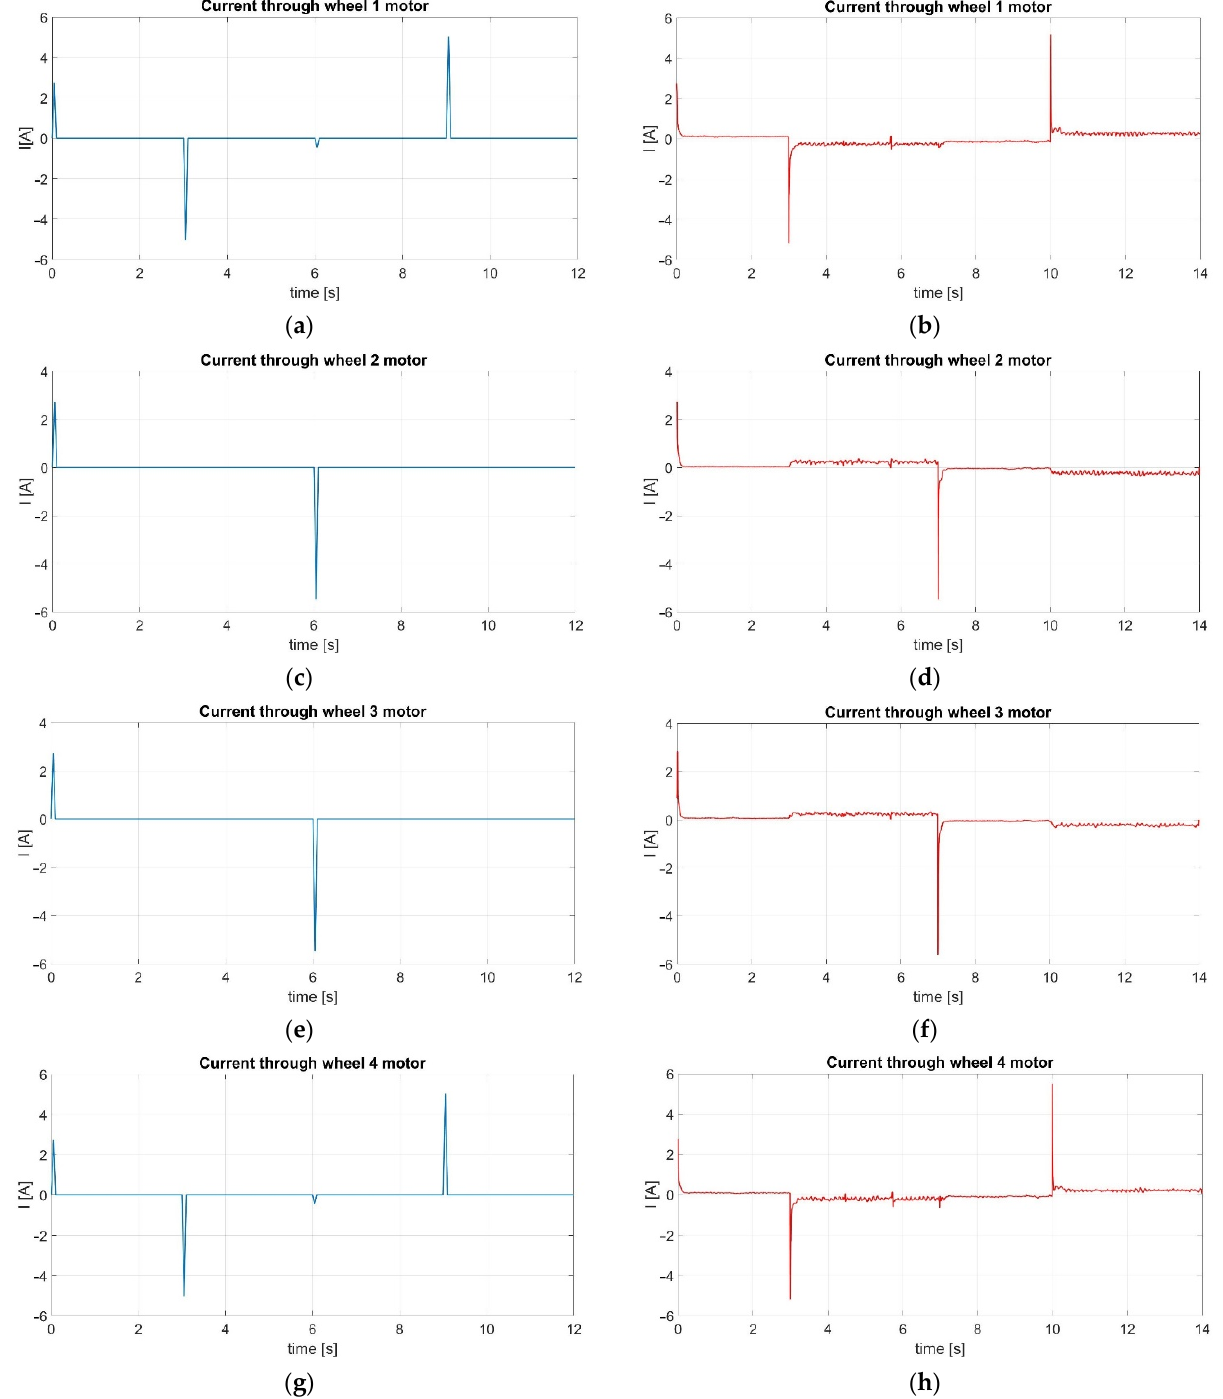
Figure 12. Comparison between simulated ( a , c , e , g ) and measured ( b , d , f , h ) currents through the wheel motors for the four-wheel Mecanum kinematic solution: ( a , b ) wheel 1; ( c , d ) wheel 2; ( e , f ) wheel 3; ( g , h ) wheel 4.